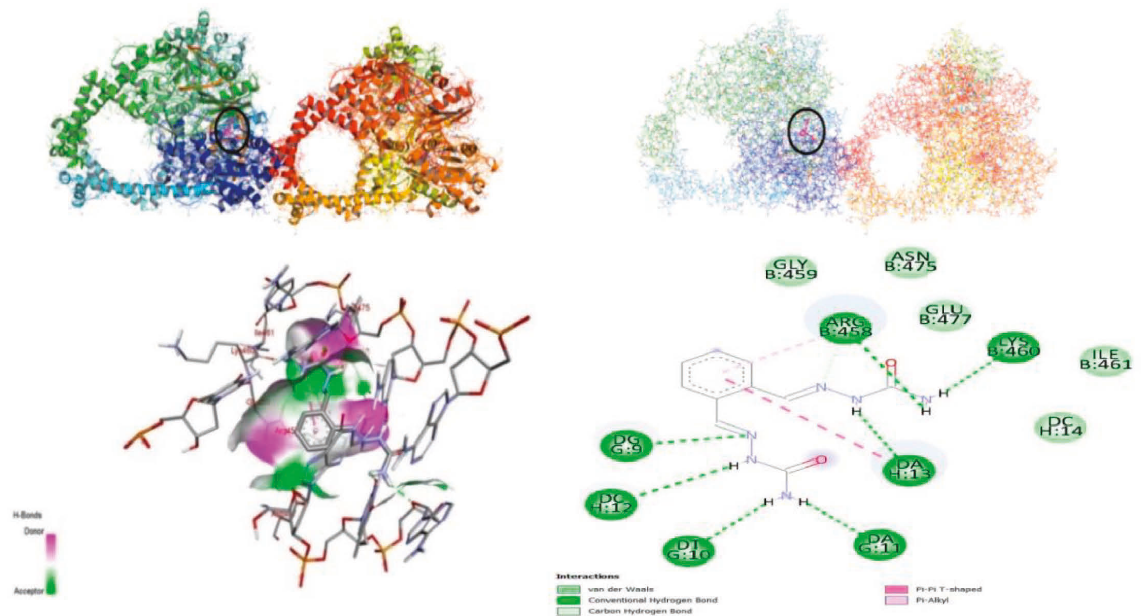
Figure 18: The L 1 binding to bacterium enzyme in two- and three-dimensional